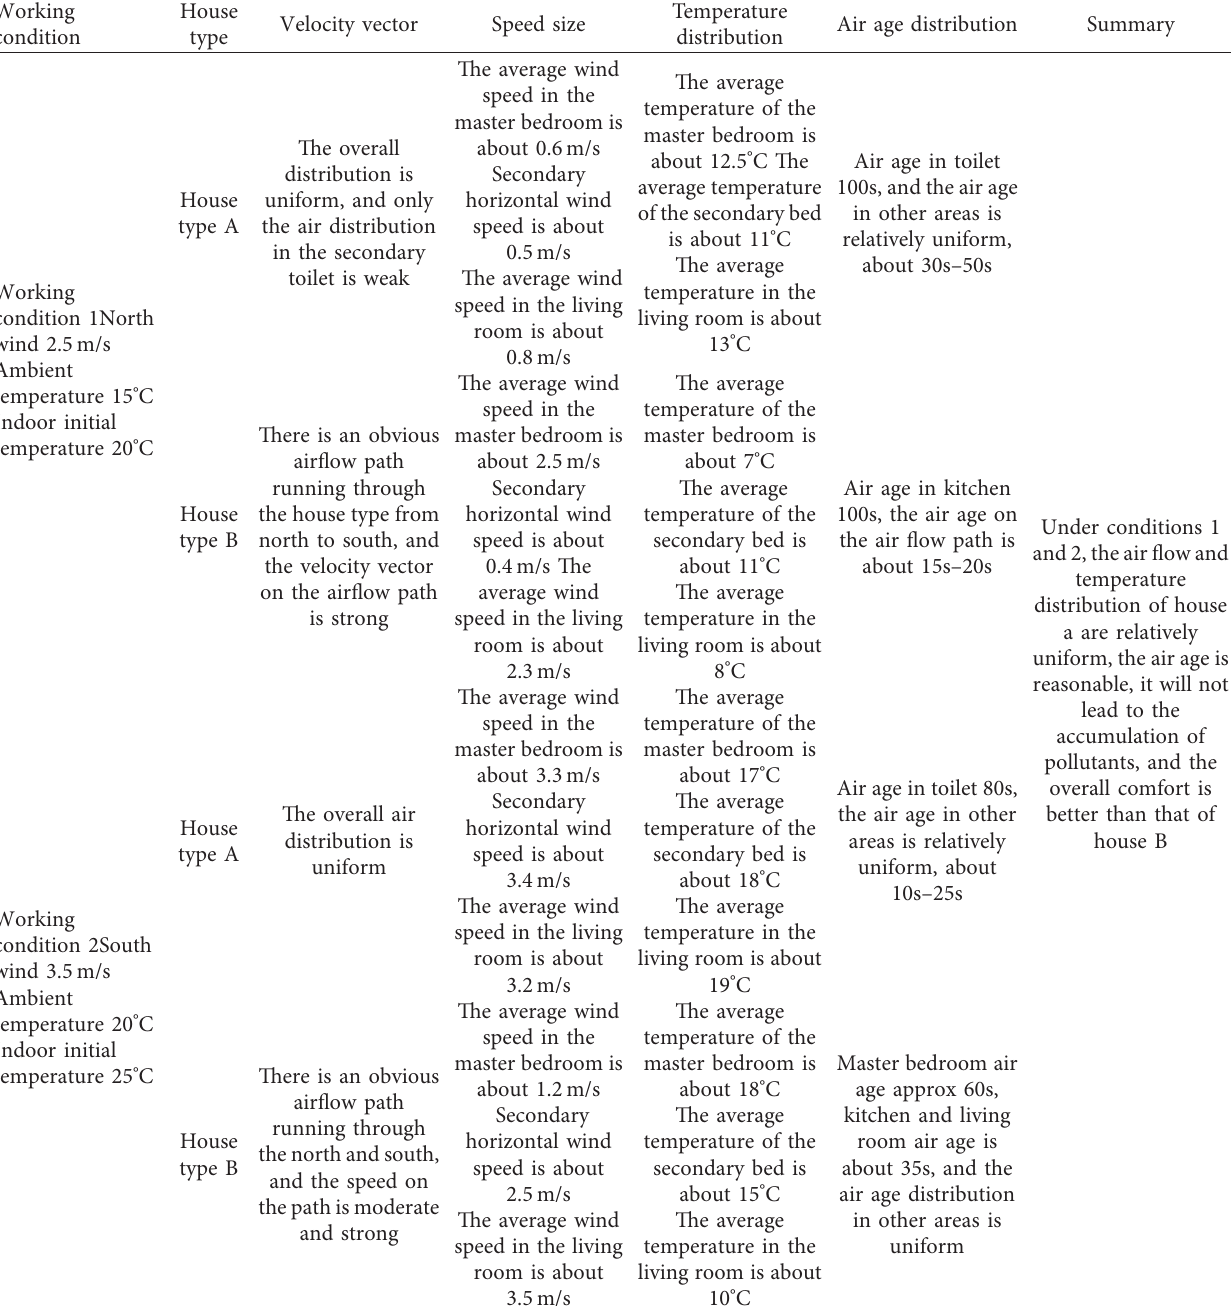
Table 3: Comparison of simulation results of two house